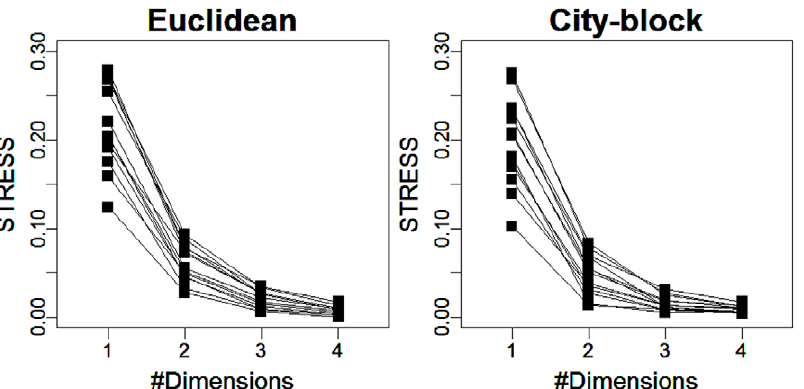
Figure 2. Stress value versus number of dimensions for 13 countries (one line corresponds to one country). (left) Euclid metric (right) City-block metric.